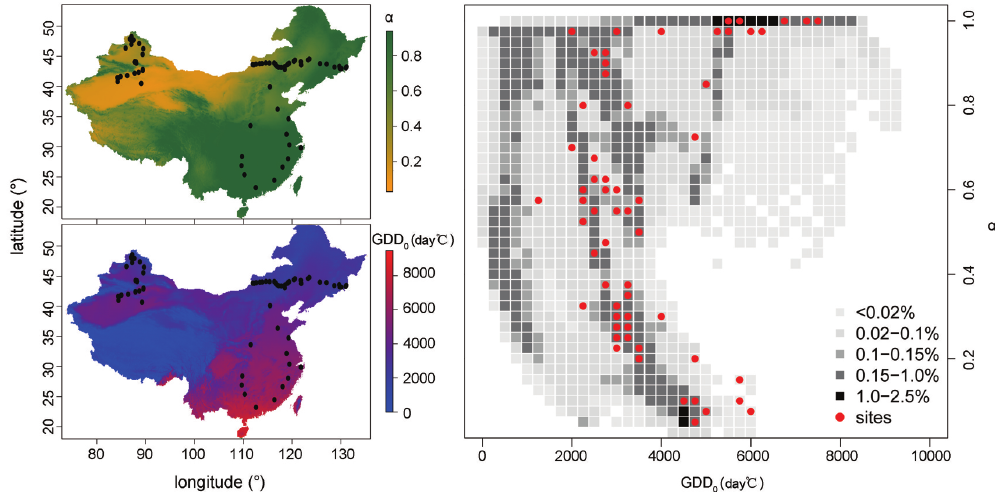
Figure 1. Left: geographic variation in the mean Cramer-Prentice moisture index ( α) and annual growing degree days above 0 ◦ C (GDD 0 ) in China. Right: frequency distribution of 10km grid cells (grey squares) and location of sampling sites (red circles) in climate